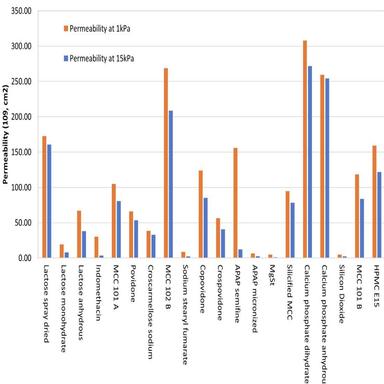
Material characterization results from permeability test at a consolidation stress of 1 kPa and 15 kPa.